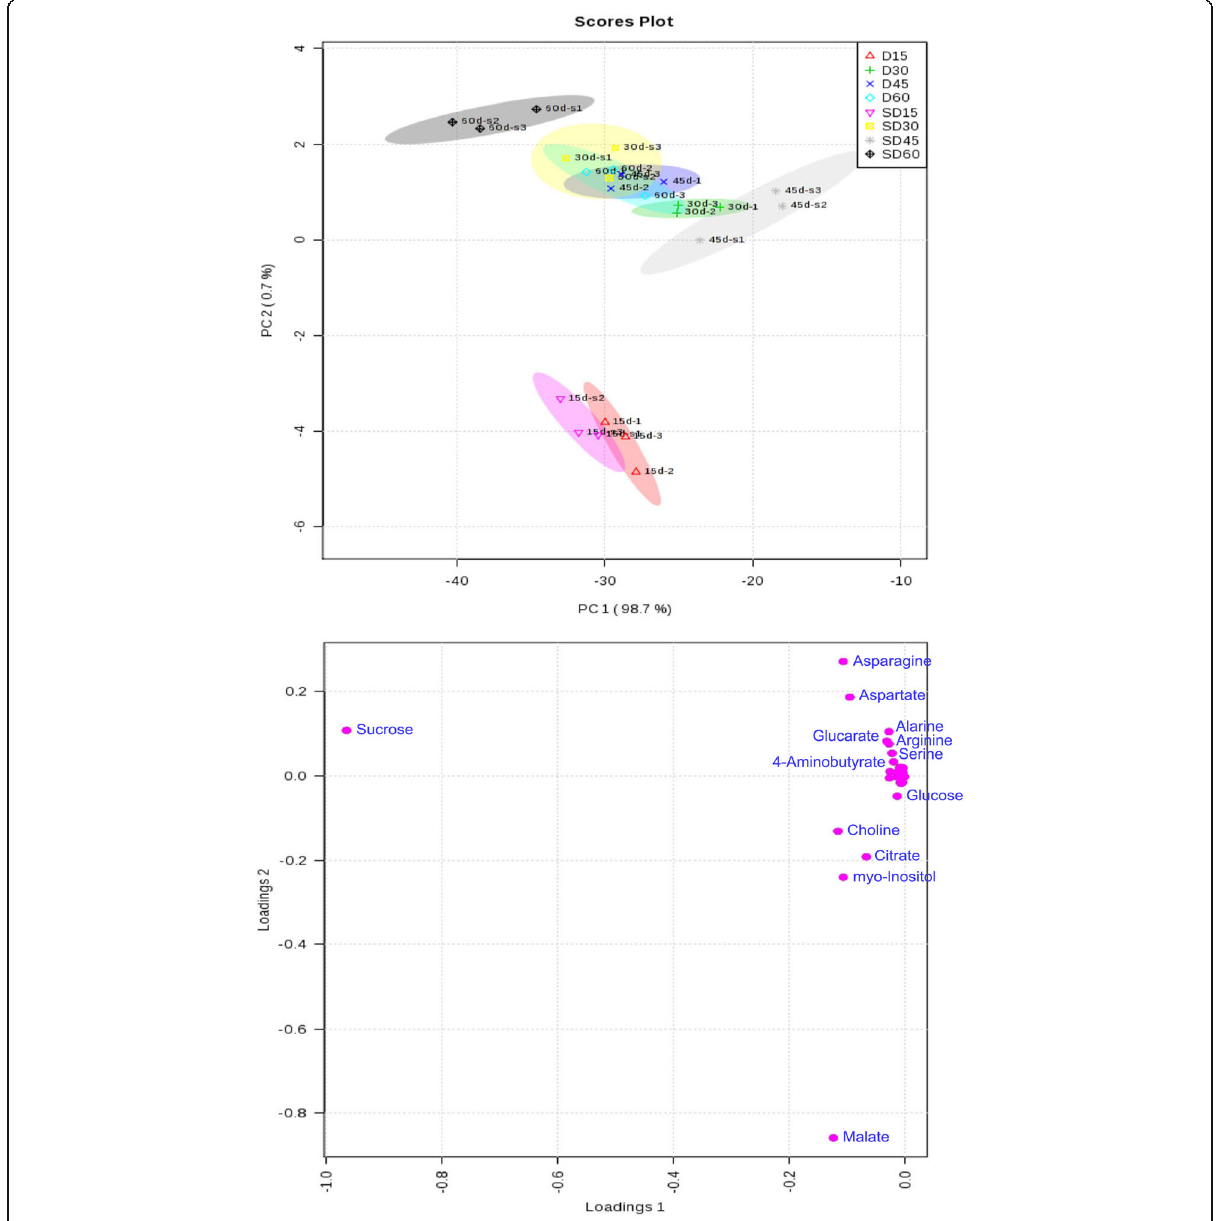
Fig. 1 Score and loading plots of effect of exogenous spermine on metabolite profiles of cold-stored immature vegetable